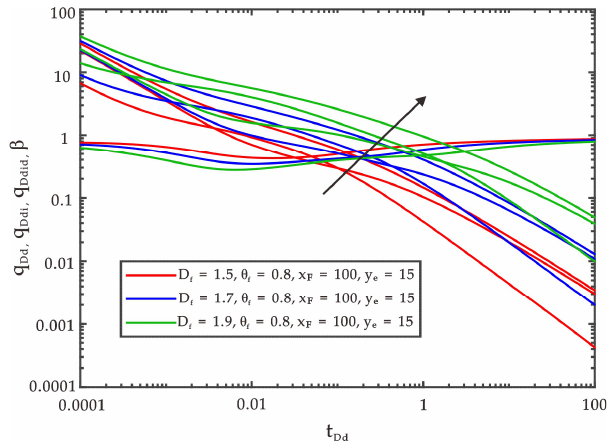
Figure 7. The sensitivity analysis of fractal dimension for the branch fracture network.